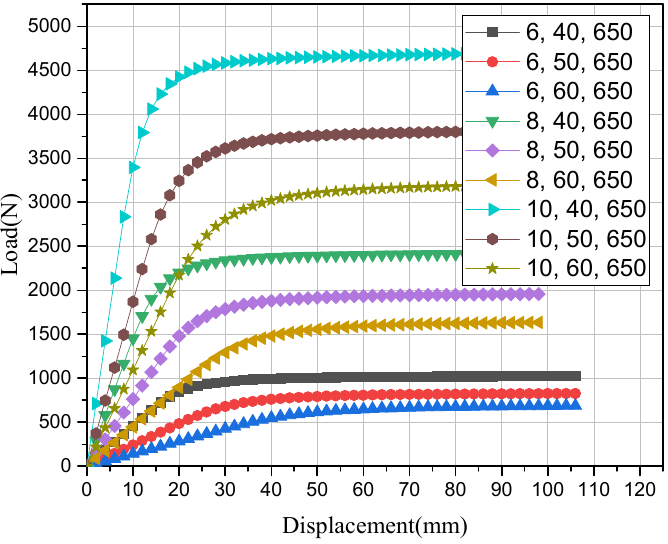
Figure 8. Load–displacement curves of SCDs ( n = 5).